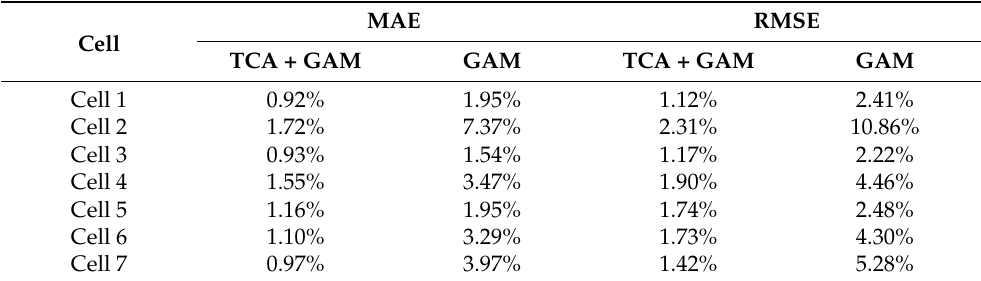
Figure 4. SOH estimation results before and after feature transfer on the Oxford battery dataset: ( a , c , e , g , i , k , m ) are the SOH prediction curves of cell 1 to cell 7; ( b , d , f , h , j , l , n ) are the predicted error curves of cell 1 to cell 7. Table 1. MAE and RMSE of SOH estimation results before and after feature